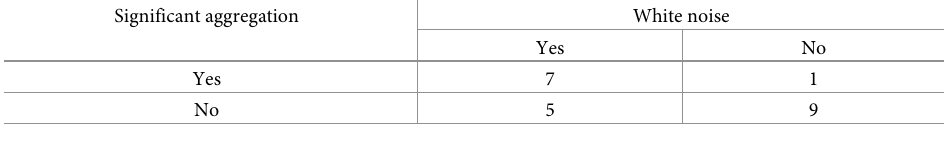
Table 2. Test of independence between the aggregation and presence of white noise for Pontomyia oceana . Significant aggregation White noise Yes No Yes 7 1 No 5 9 P = 0.03, Fisher’s exact